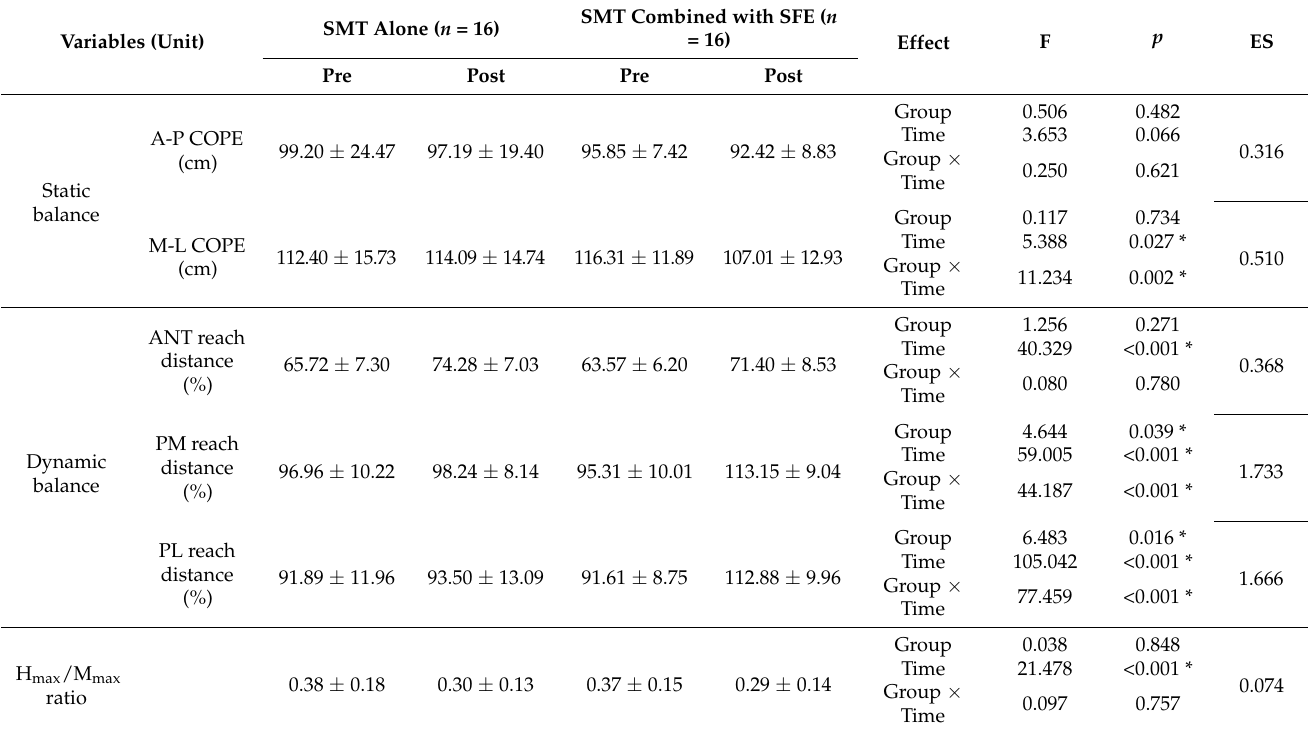
Table 3. Outcome measures for pre and post test in both sensorimotor training and combined exercises groups. Variables (Unit)